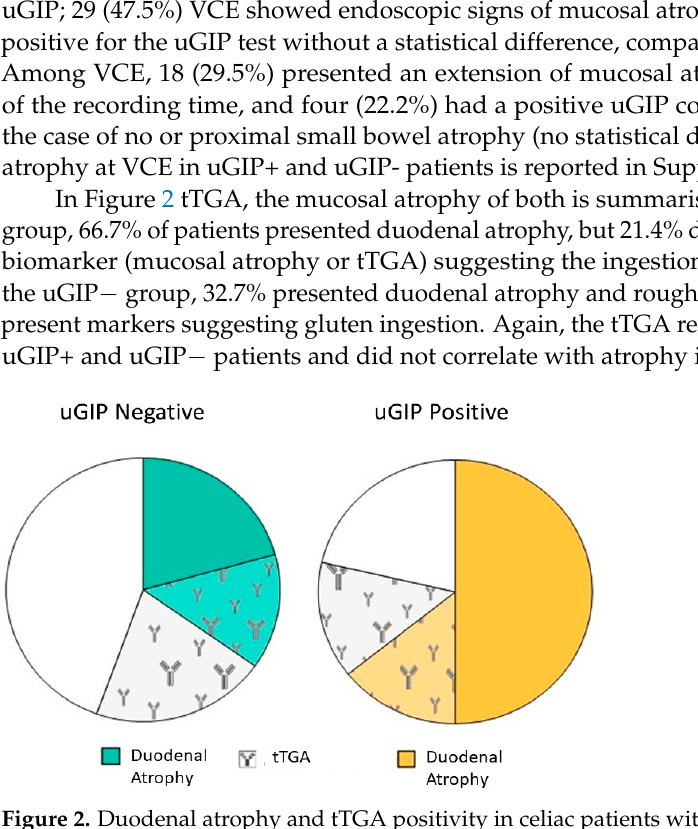
Figure 2. Duodenal atrophy and tTGA positivity in celiac patients with or without a uGIP positive